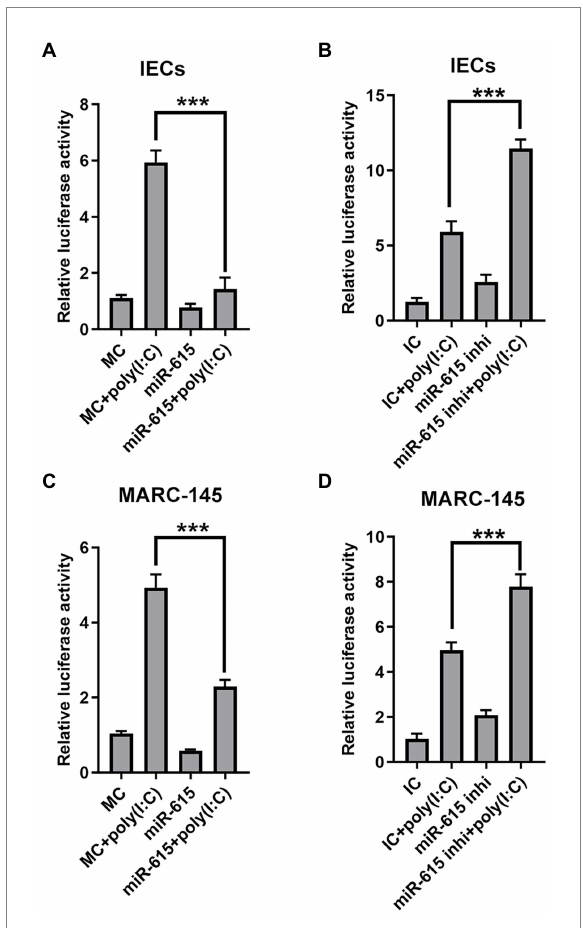
FIGURE 4 miR-615 inhibits NF- κ B activation. Luciferase activity in IECs and MARC-145 cells. Cells were co-transfected using a dual- luciferase reporter system (pNiFty-luc and pRL-TK vectors, the activities of which indicate NF- κ B-promoter activation) and miR- 615 mimics or inhibitors for 24 h, and stimulated with poly (I:C) for 24 h during PEDV infection at a multiplicity of infection (MOI) of 1. Luciferase reporter activity of the miR-615 mimics in IECs (A) and MARC-145 cells (C) . Luciferase reporter activity of the miR-615 inhibitors in IECs (B) and MARC-145 cells (D) . The data are representative of three independent experiments (mean ± SD). *** p <